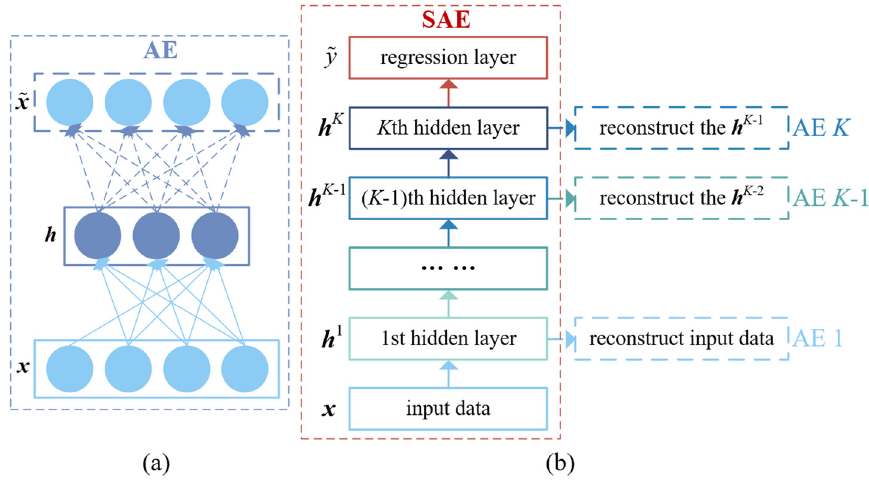
Figure 3: Structure for AE and SAE. ( a ) AE network. ( b ) SAE network with